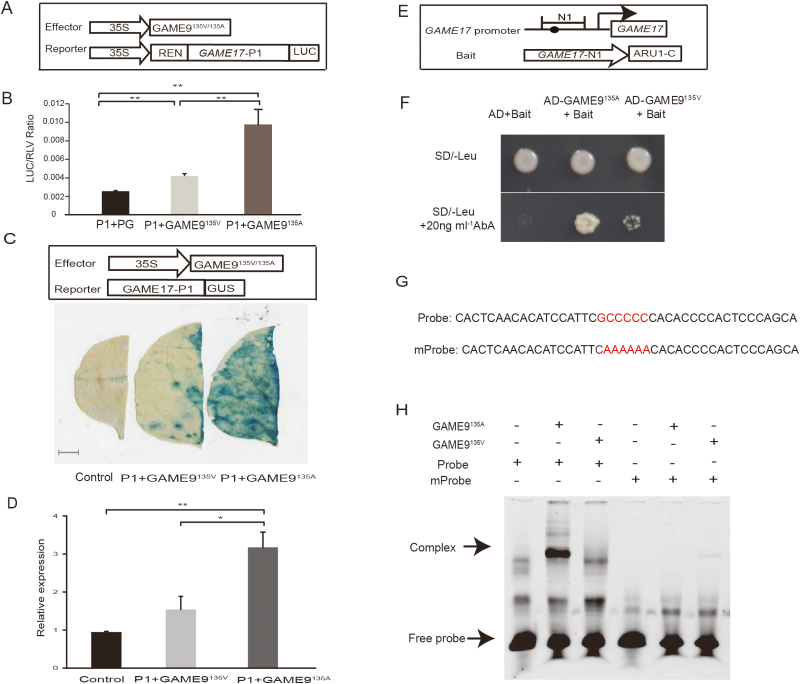
Transactivation of GAME17 promoters by GAME9135A and GAME9135V. (A) Schematic diagrams of the constructs used for the dual luciferase assay. The reporter constructs were created by cloning promoter fragment of GAME17, P1 (−898 bp to the translational start codon), into pGreen II 0800-Luc. The effector constructs were created by cloning the full-length open reading frames of GAME9135A and GAME9135V into pGreen II 62-SK. (B) Transactivation activity of GAME9135A and GAME9135V on the GAME17 promoter in tobacco leaves. LUC, firefly luciferase activity; RLU, Renilla luciferase activity. The P1 and the pGreen II 62-SK empty (PG) vector were used as controls. Bars represent mean values ±SE (n>6). Asterisks indicate statistically significant differences determined using a t-test: **P<0.01. (C) GUS activity of GAME9135A and GAME9135V on the GAME17 promoter in tobacco leaves. Schematic diagrams of the constructs used for the GUS activity assay are shown at the top. P1: the promoter fragment of GAME17 (−898 bp to the translational start codon). P1 and pHellsgate8 empty vector were used as controls. Scale bar, 1 cm. (D) GUS expression level driven by GAME9135V and GAME9135A effector. The control and fragment of GAME17 promoter correspond to those shown in (C). A validation experiment (n=4) was performed. Asterisks indicate statistically significant differences determined using a t-test: *P<0.05, **P<0.01. (E) Schematic diagrams of the GAME17 promoter and reporter constructs used for the Y1H assay. The circles indicate the cis-acting GC-rich element (−724 to −717 bp) within the GAME17 promoter. N1 (−898 to −378 bp) indicates the promoter fragments of GAME17 that were cloned into the bait plasmid pAbAi. (F) GAME17 promoter-binding activity of GAME9135A and GAME9135V. The promoter binding activities were determined using a Y1H assay. The bait vector and the empty pGADT7 vector were co-transformed into Y1Gold as a negative control. All transformants were grown on a selective medium containing (top) or lacking (bottom) 20 ng ml−1 antibiotic (AbA). (G) Wild-type and mutant probes were used for EMSAs. The wild-type probe was synthesized based on the GAME17 promoter sequence. The cis-element sequence was replaced with AAAAAA in the mutant probe (mProbe). The hypothetical cis-element is indicated with shaded letters. (H) In vitro binding of GAME9135A and GAME9135V to the promoter of GAME17. −, absence; +, presence. The protein–DNA complex and free probe are indicated. (This figure is available in color at JXB online.)